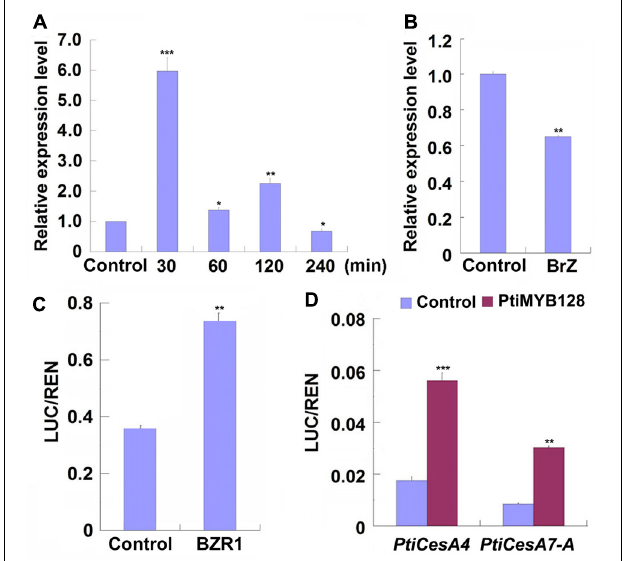
FIGURE 6 | PtiMYB128 was regulated by BZR1 and positively regulates the expression of PtiCesAs . (A,B) MYB128 was induced by EBL but suppressed by Brz. The transcription levels of MYB128 in the TW xylem of wild type Shangxin yang (WT) stems treated with 100 nM EBL or 5 mM Brz were investigated. (C) BZR1 regulated the promoter of PtiMYB128. The control vector or pGreenII62-SK- AtBZR1 were co-expressed with 35S : REN - ProPtiMYB128:LUC in the leaf protoplasts of WT poplar. LUC/REN ratios represent the promoter activity of PtiMYB128 activated by the Arabidopsis BZR1 (AtBZR1). Control, protoplasts co-transfected with pGreenII62-SK and 35S : REN - ProPtiMYB128:LUC ; BZR1, protoplasts co-transfected with pGreenII62-SK-AtBZR1 and 35S : REN - ProPtiMYB128:LUC . (D) PtiMYB128 regulated the promoters of PtiCesA4 and PtiCesA7-A . The control or pGreenII62-SK- PtiMYB128 vector were co-expressed with the reporters 35S : REN - ProPtiCesA4:LUC or 35S : REN - ProPtiCesA7-A:LUC in the leaf protoplasts of WT poplar, respectively. LUC/REN ratios represent the promoter activity of PtiCesA4 and PtiCesA7-A activated by PtiMYB128. Control, protoplasts co-transfected with pGreenII62-SK and each reporter; PtiMYB128, protoplasts co-transfected with pGreenII62-SK- PtiMYB128 and each reporter. Data were means ± SD ( n = 3) of three independent biological replicates with three technical replicates each. *, **, and *** indicate significant difference at P < 0.05, P < 0.01, and P < 0.001, respectively (Student’s t